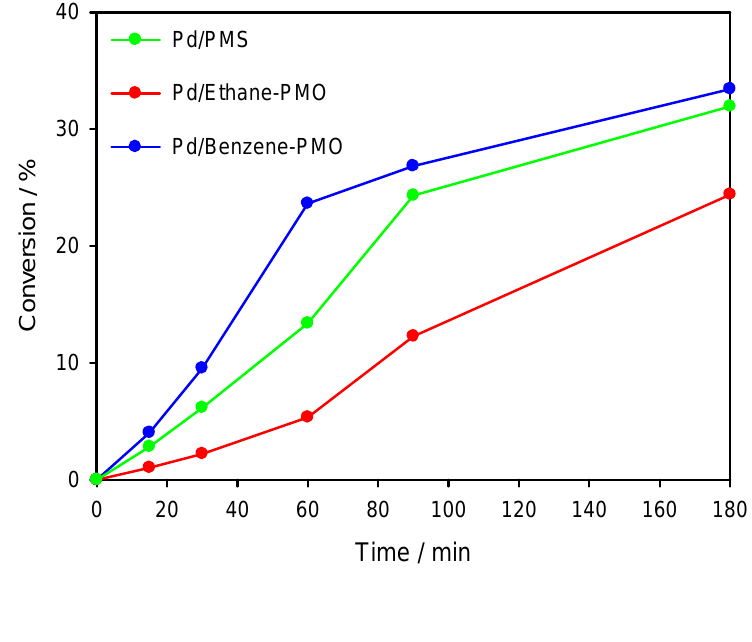
Figure 5. Overall conversion (mol%) in the Suzuki coupling of bromobenzene with phenylboronic acid on Pd-supported mesoporous